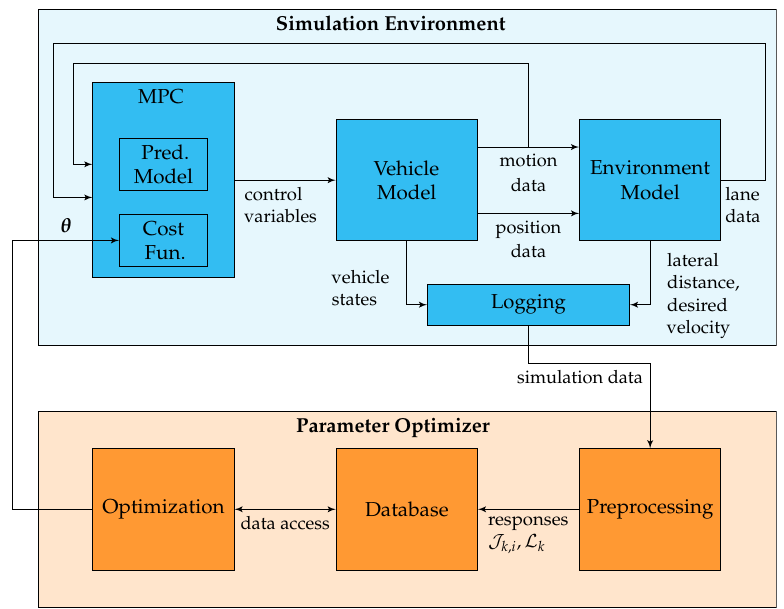
Figure 1. Controller tuning framework consisting of the simulation environment (depicted in blue) and the parameter optimizer (depicted in orange). The parameter optimizer uses simulation data from the simulation environment to produce a specific parameter vector θ , used in the MPC. For a detailed view of the MPC implementation and the variables involved, see Figure